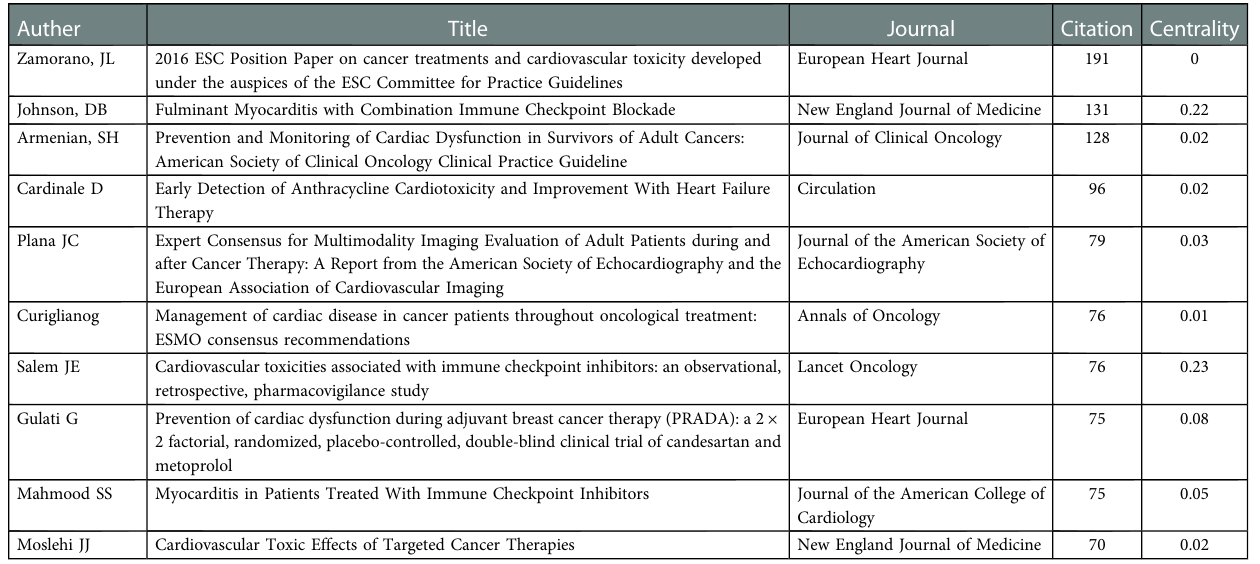
TABLE 7 The top 10 cardiotoxicity references with the most citations.